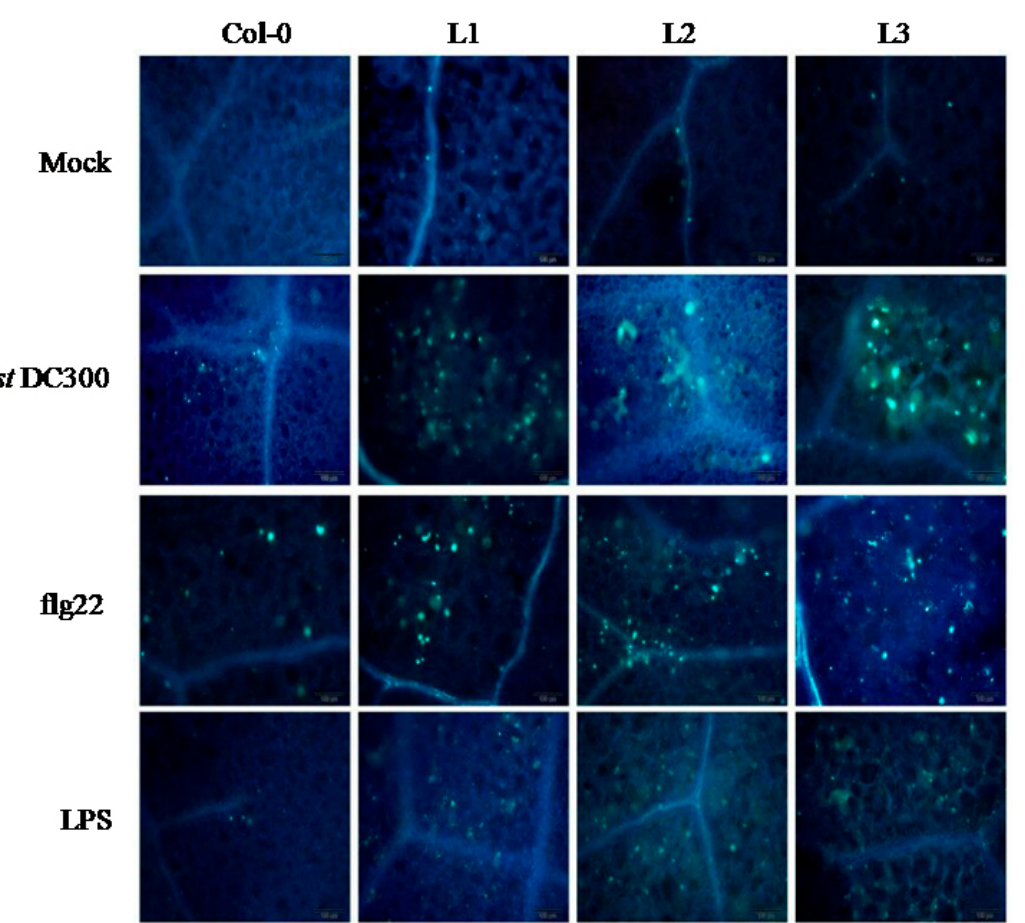
Figure 7. Callose deposition in transgenic A. thaliana and Col-0 leaves. Four-week old leaves were stained with aniline blue following inoculation with Pst DC3000, flg22 or LPS. Experiments were repeated three times with at least 5 leaves showing disease each repetition. The scale bar in the figure indicates 100 µm.